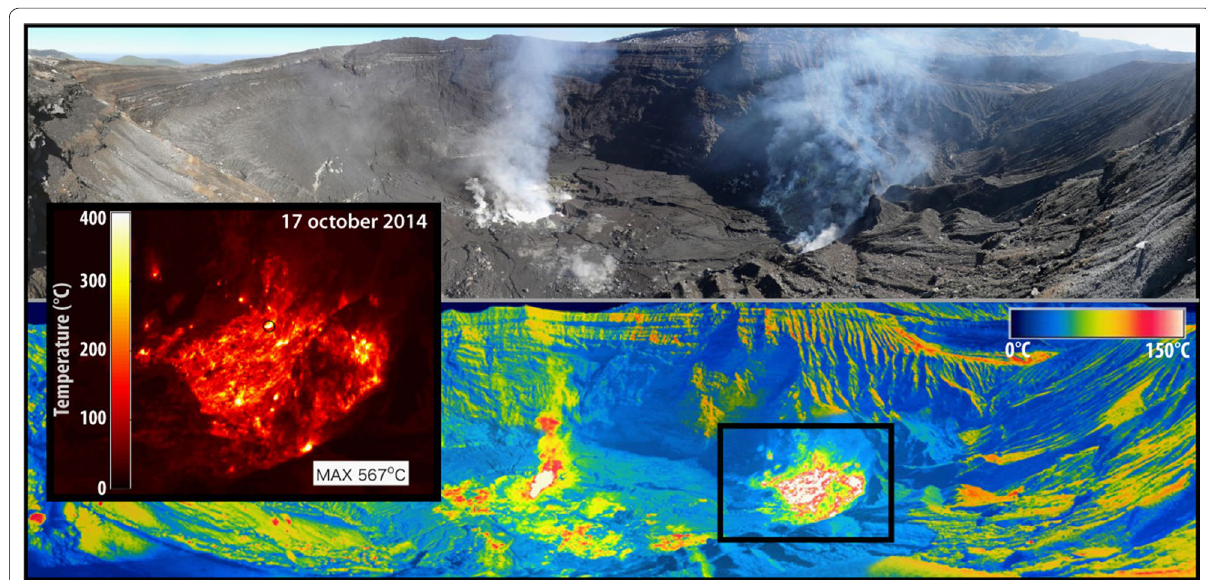
Fig. 5 Visible and thermal infrared panoramic images taken from the fixed observation position at Aso Crater 1 rim (star in Fig. 1) on October 17, 2014. Inset shows the image of the fumarole field located in the South Area (indicated by the black rectangle) with the maximum apparent tem- perature recorded during ground-based